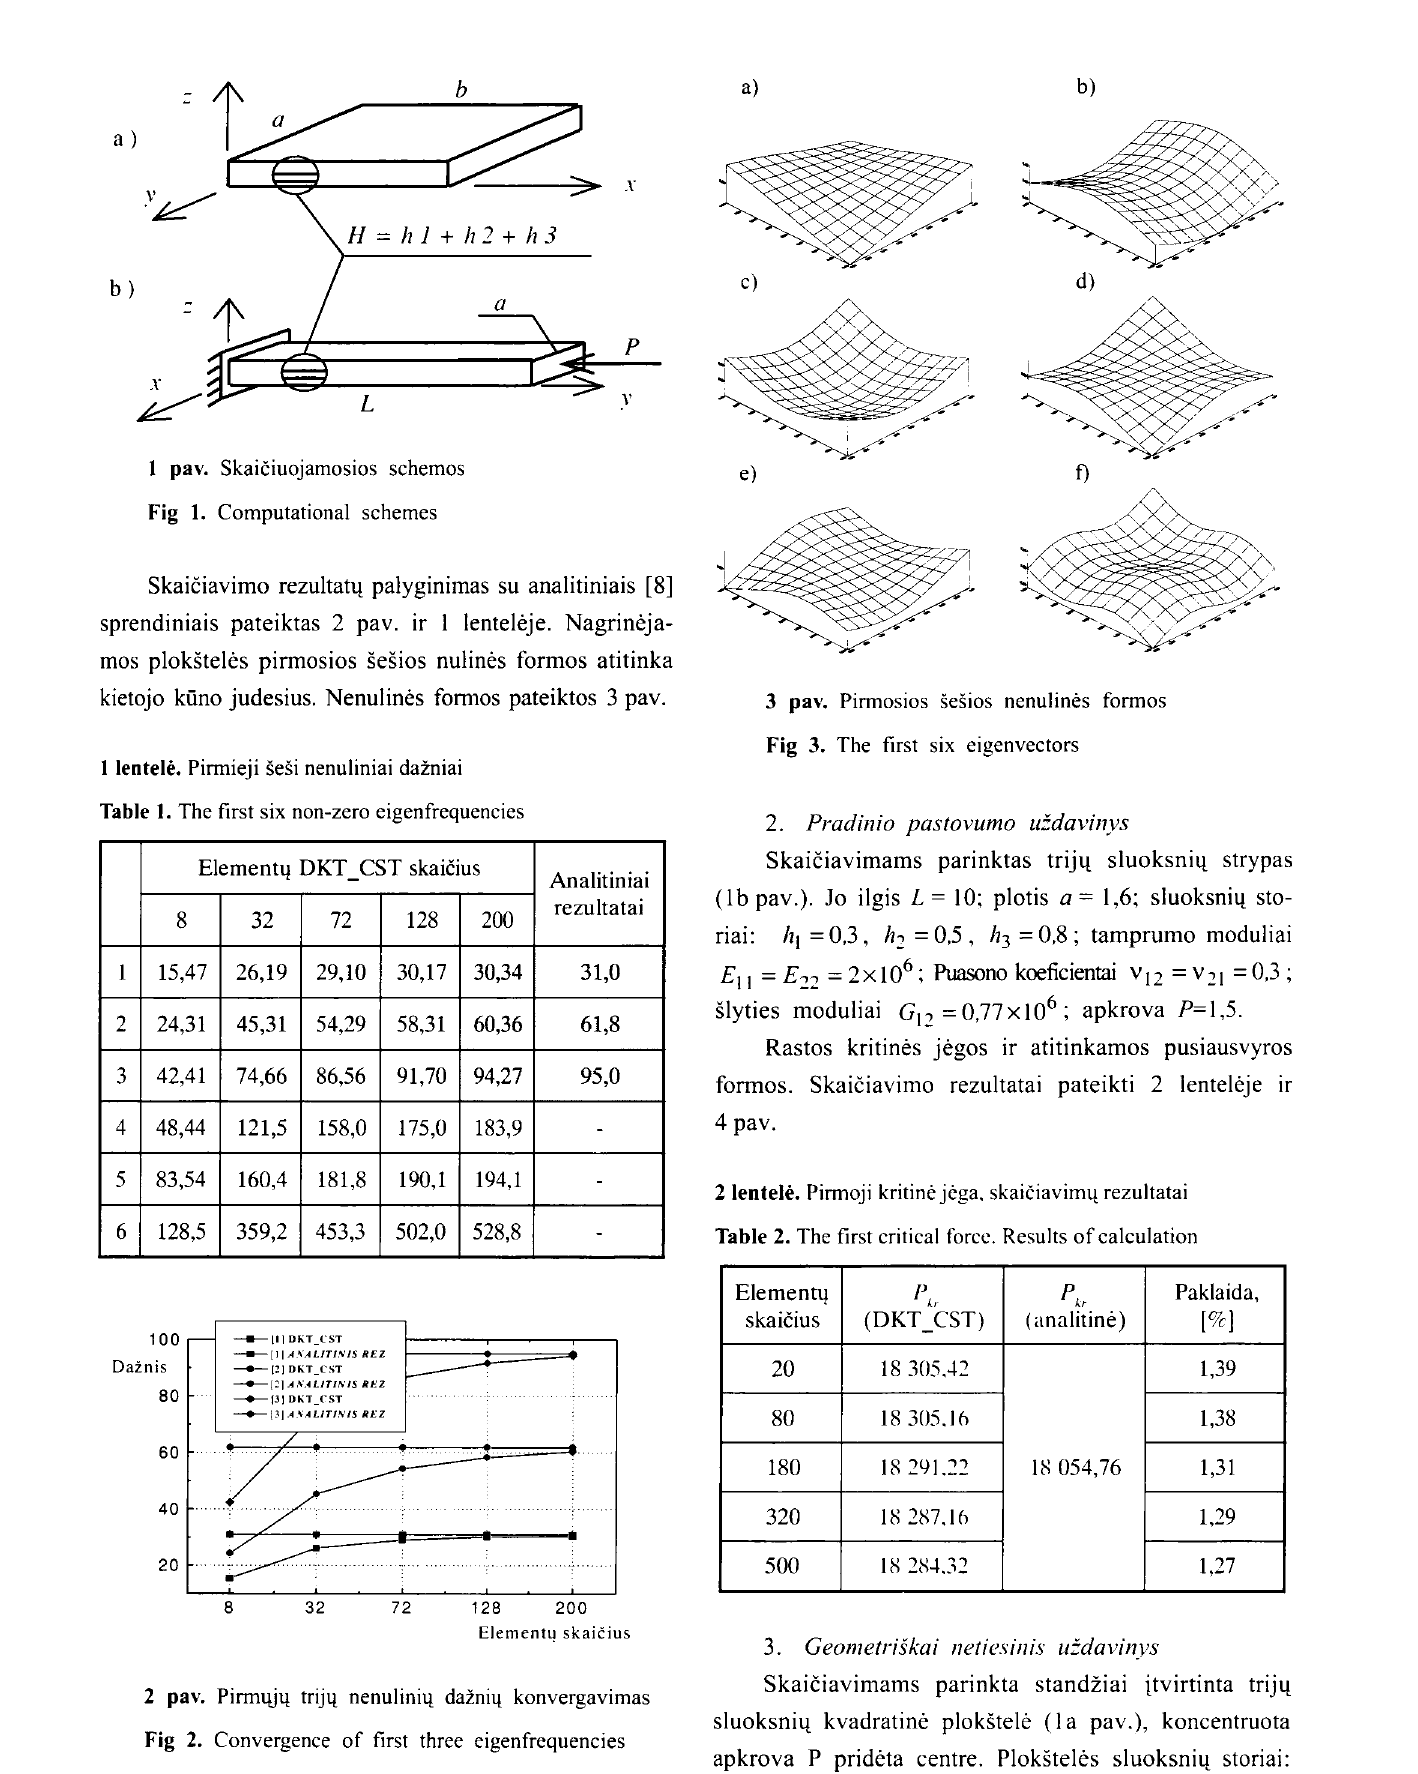
Fig 2. Convergence of first three eigenfrequencies